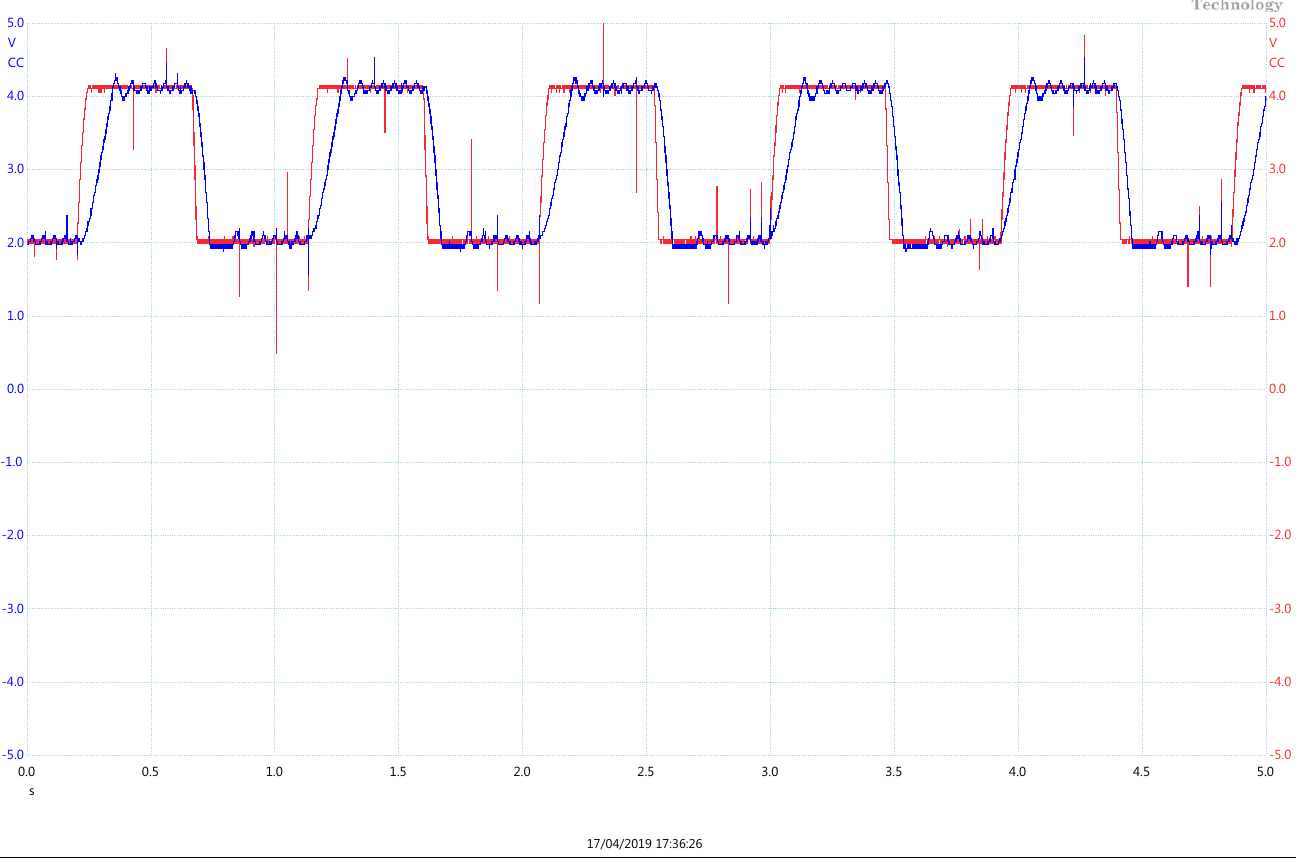
Figure 8. Experimental answers. The blue line is the measured throttle angular position and the red line is the programmed desired trajectory. Here, the given reference statement is a square representation. The main objective of this reference profile is to evaluate the settling-time of the controller under step-variation of the reference command. In the wind turbines application, this settling-time is not required to be